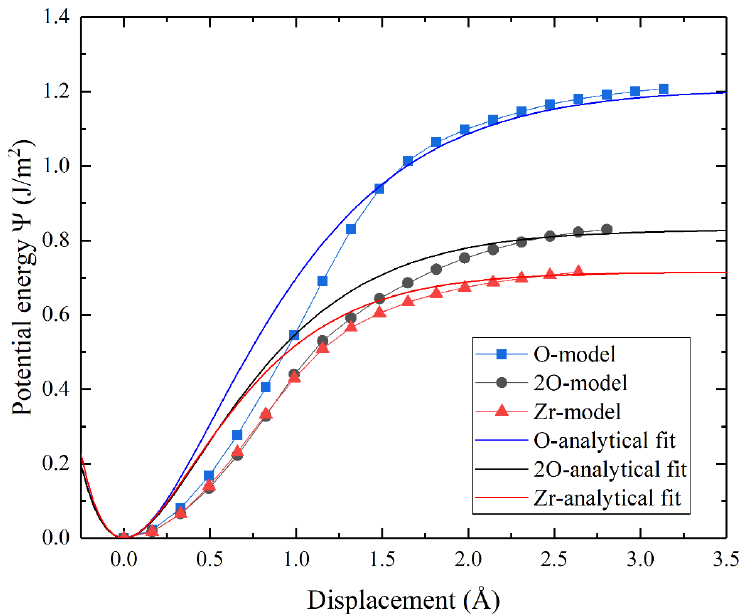
Figure 5. The potential energy-displacement curve of the three terminated c-ZrO 2 (001)/α -Al 2 O 3 (1102) interfaces. The analytical curves based on Equation (2) and the curves from first-principle calculations are shown as well.